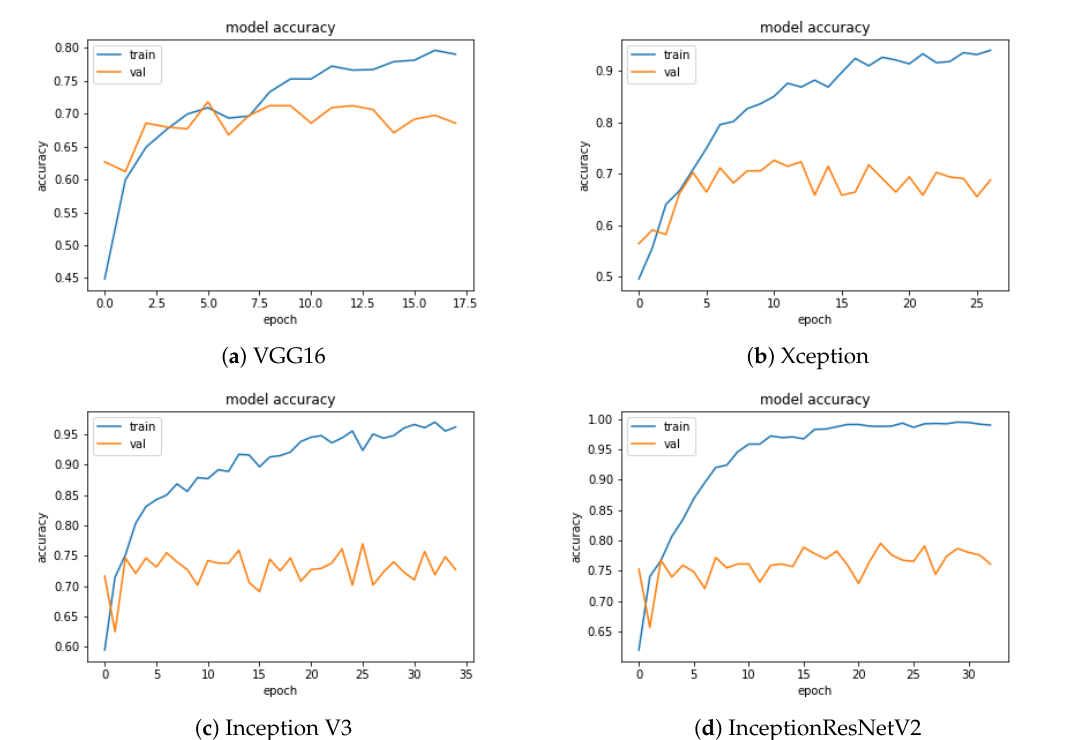
Figure 6. Accuracy function evolution for each network as a function of the